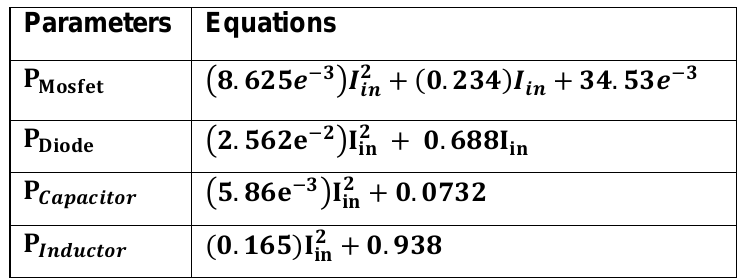
Table 1: Loss evaluation equations